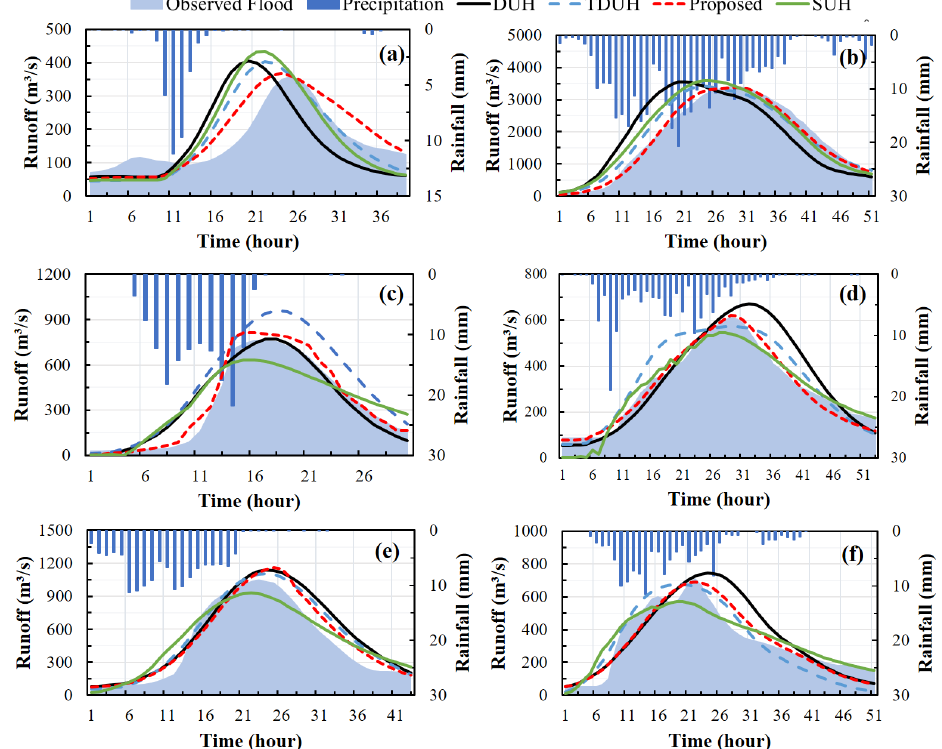
Figure 13. Comparison of flow hydrographs obtained by the four methods. (a) Flow event no. 20130720. (b) Flow event no. 20130817. (c) Flow event no. 20150709. (d) Flow event no. 20160128. (e) Flow event no. 20161021. (f) Flow event no. 20180916.